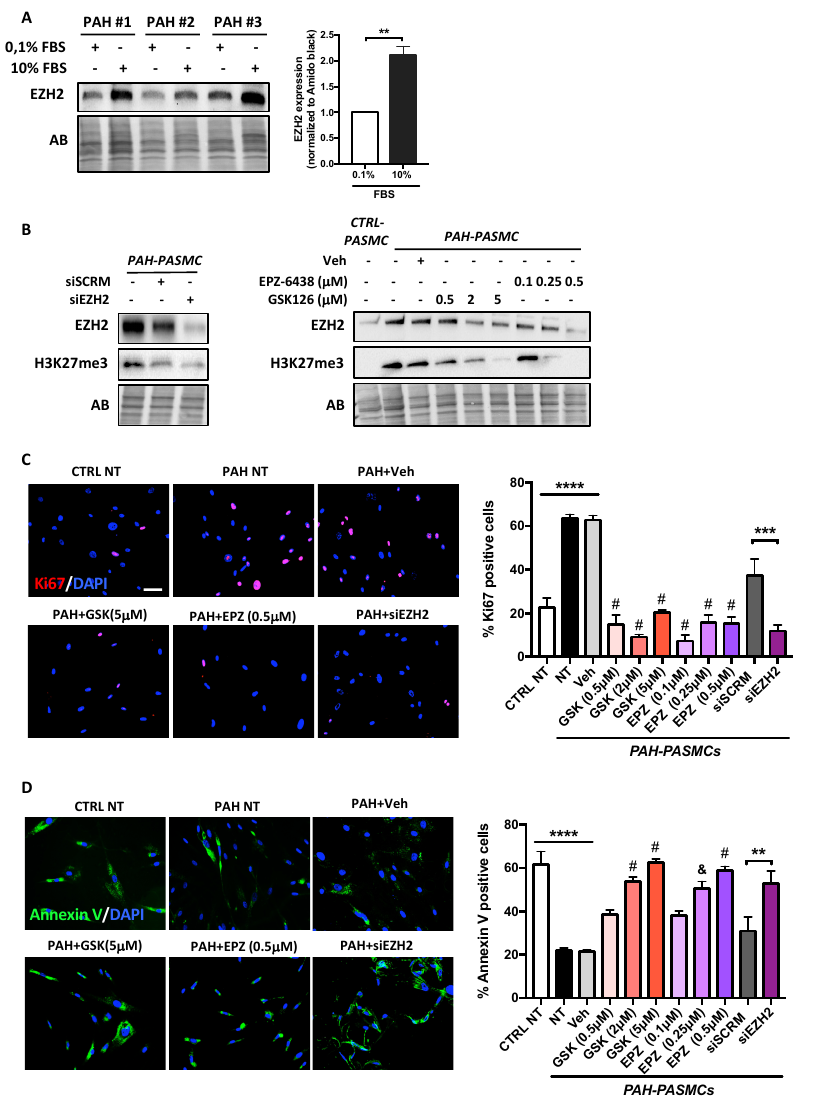
Figure 2. Effects of molecular and pharmacological inhibition of EZH2 on PAH-PASMCs proliferation and resistance to apoptosis. ( A ) Western blot and corresponding densitometric analysis of EZH2 in PAH-PASMCs that were serum-starved or not for 48 h; ( B ) Representative Western blots of EZH2 and H3K27me3 in PAH-PASMCs treated with either EZH2 small interference siRNA or nontargeting scrambled (siSCRM) or escalating concentrations of GSK126 and EPZ-6438 (two catalytic EZH2 inhibitors) for 48 h; ( C ) Proliferation (Ki67) was measured in control ( n = 5) and PAH-PASMCs ( n = 5) treated or not with siEZH2, GSK126, and EPZ-6438 or their respective controls for 48 h. Graph shows the percentage of cells with positive nuclear Ki67 staining. PAH-PASMCs are significantly more proliferative than control PASMCs. Pharmacological inhibition of EZH2 or its knockdown decreases PAH-PASMC proliferation; ( D ) Apoptosis (Annexin V) was measured in serum-starved control ( n = 5) and PAH-PASMCs ( n = 5) treated or not with siEZH2, GSK126, and EPZ-6438 or their respective controls for 48 h. Graph shows the percentage of cells with positive Annexin-V staining. PAH-PASMCs are more resistant to starvation-induced apoptosis than control cells. Pharmacological inhibition of EZH2 or its knockdown increases PAH-PASMC apoptosis. Scale bar = 50 µ m. Data are presented as mean ± SEM; ** p < 0.01; *** p < 0.001; **** p < 0.0001; and & p < 0.001 compared with Veh and # p < 0.0001 compared with